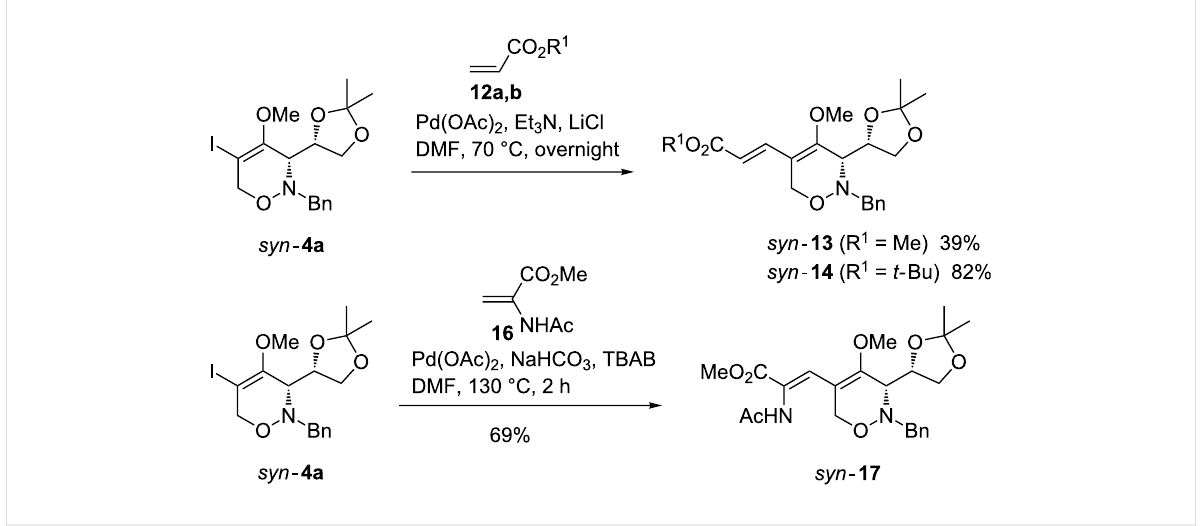
Scheme 5: Heck reactions of 1,2-oxazine syn - 4a leading to 5-alkenyl-substituted 1,2-oxazines syn - 13 , syn - 14 and to dehydroamino acid syn - 17